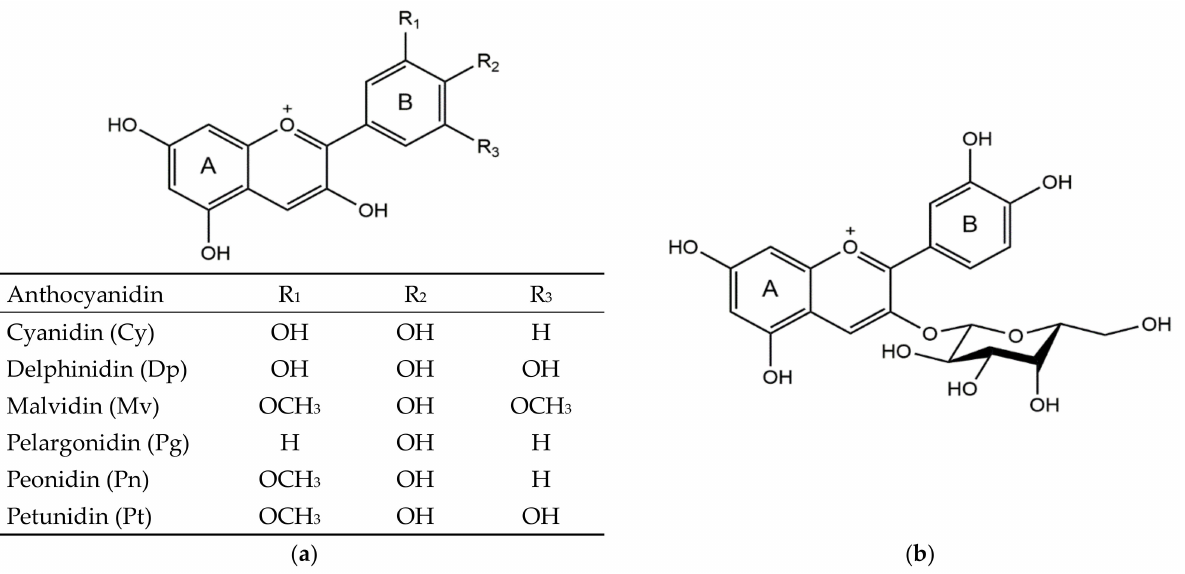
Figure 1. Structures of six common anthocyanidins ( a ) and cyanidin 3- O -galactoside ( b